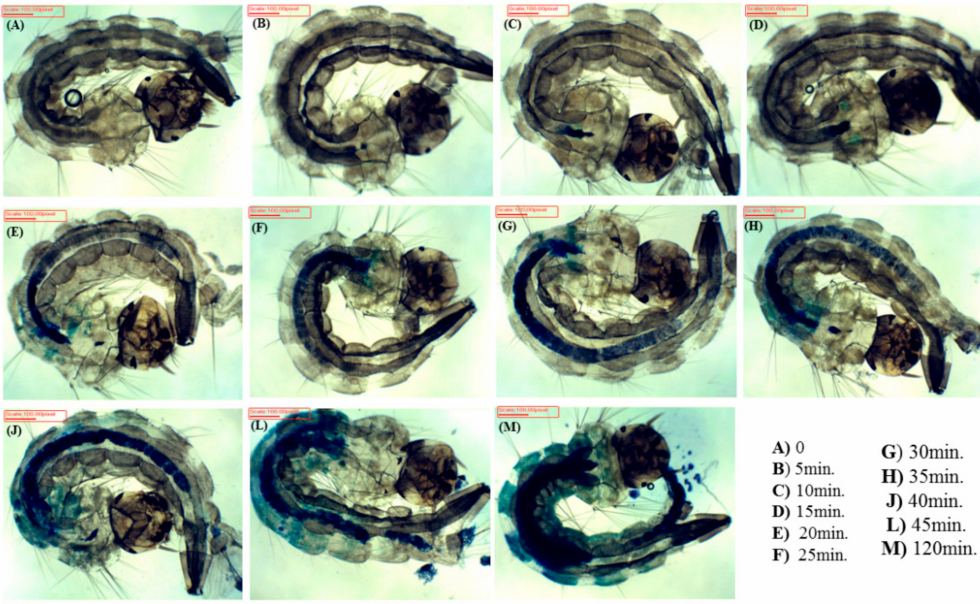
Figure 2. Images of Aedes aegypti larvae after their immersion in photosensitizer (PS) aqueous solution of EMB as a function of immersion